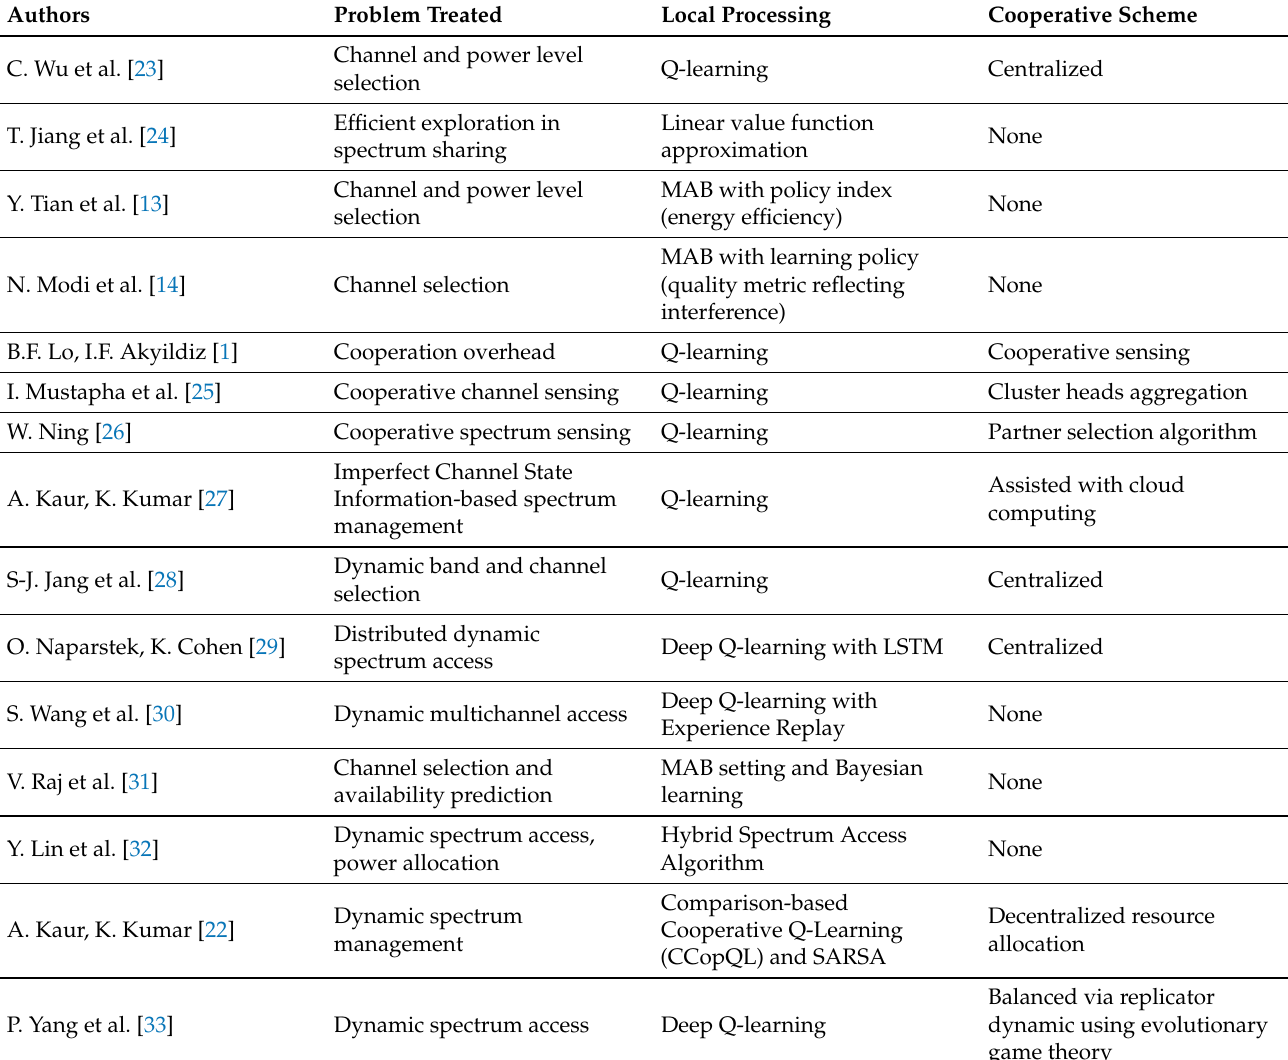
Table 1. Overview of related